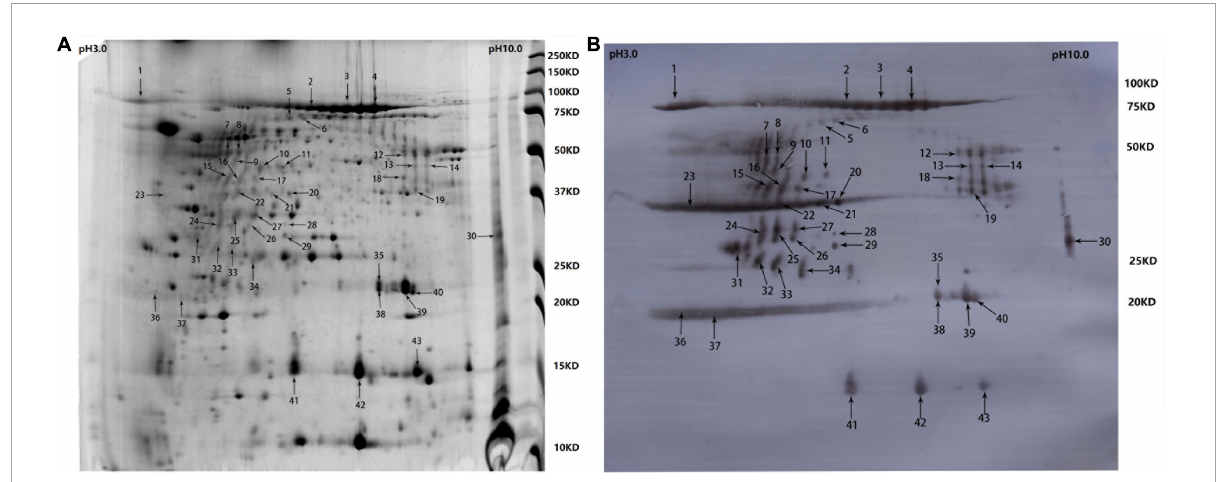
FIGURE1 Two-dimensional electrophoresis (2-DE) gel and western blotting profile of cell-free culture supernatant of R. anatipestifer strain Yb2. (A) Separation of trichloroacetic acid (TCA)-precipitated proteins from the culture supernatant of R. anatipestifer Yb2 (200 µ g) with 2-DE over pH 3–10 (stained with Coomassie Brilliant Blue G-250). Sites of excised spots are shown with arrows. (B) Western blotting analysis of the proteins on 2-DE gel, probed with convalescent duck serum against R. anatipestifer strain